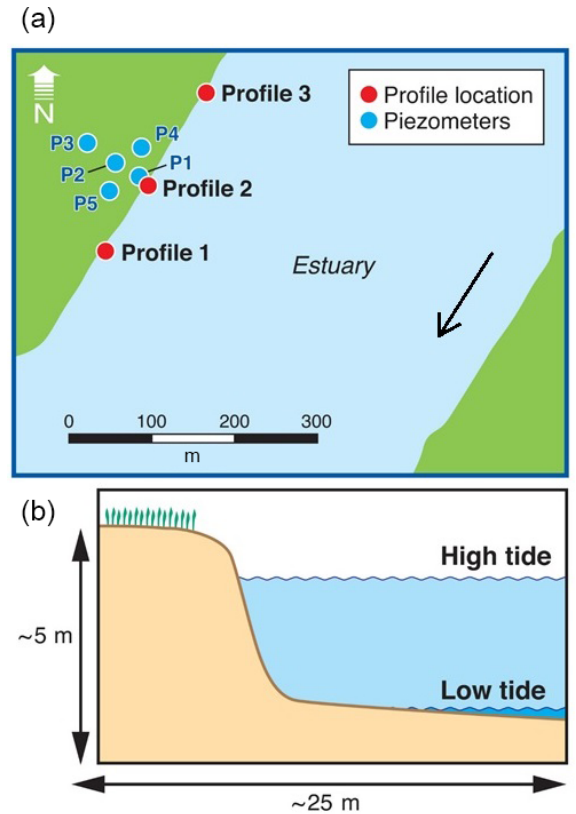
Figure 2. Location of the porewater profiles (a) and a schematic cross section of the intertidal zone (b) . Also indicated is part of the piezometer network previously installed at the site, approximately aligned with the zone with the most contaminated